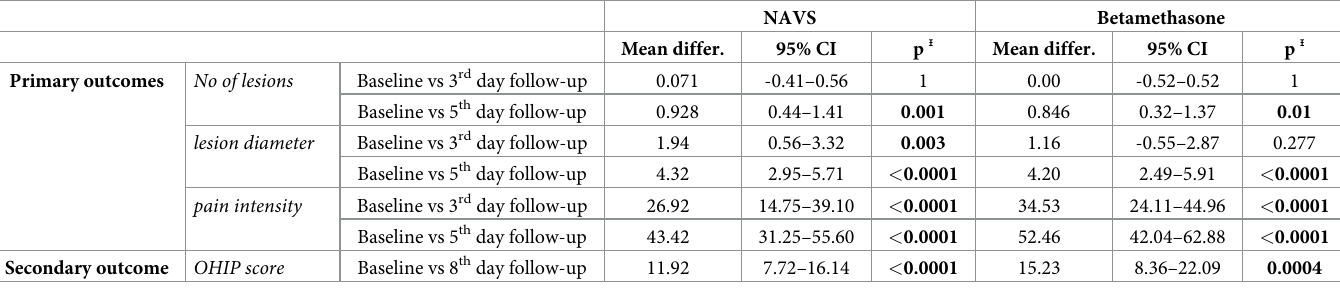
Table 7. Within groups ANOVA—Post-hoc pairwise comparisons (RAS patients).